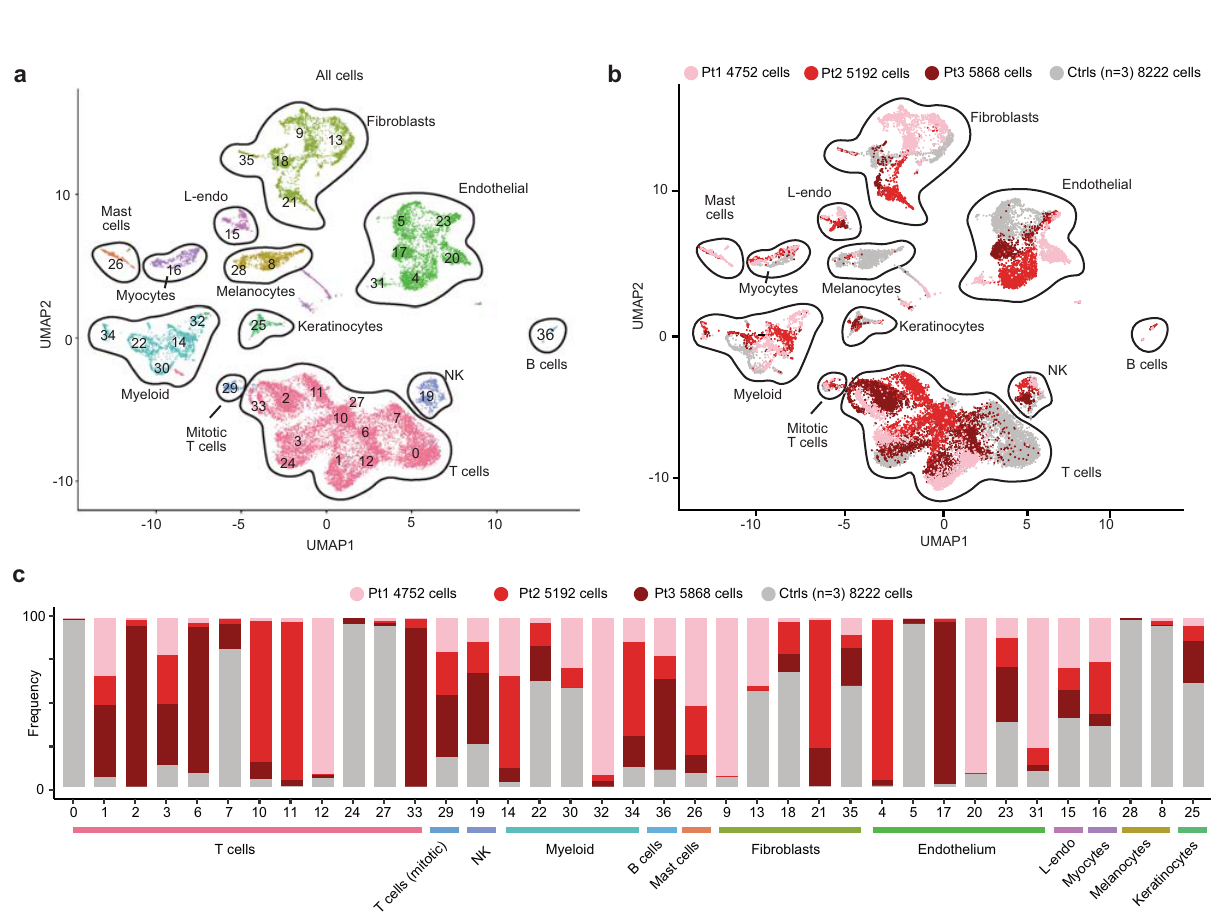
Fig. 2 Tofacitinib treatment leads to improvement in pulmonary and myocardial sarcoidosis. a, b PET (coronal) and PET-CT (axial) studies before and after 6 months of tofacitinib in patients with complete or near complete internal organ response, TLG: total lesional glycolysis. c PET (coronal) studies before and after 6 months of treatment in a patient with improvement in lymph node avidity below the threshold of quanti fi cation. d PET (coronal) studies before and after 6 months of treatment in a patient with a slight increase in PET avidity which was felt to be clinically insigni fi cant. e Cardiac PET-CT (coronal) before and after 6 months of treatment in a patient myocardial involvement of the inferior intraventricular septum (arrow), CMA: cardiac metabolic activity. f Scatterplot comparing change in cutaneous sarcoidosis and extra-cutaneous sarcoidosis. Depicted as simple linear regression line with 95% con fi dence interval (shared area), Goodness of Fit represented by R squared. Cutaneous involvement shown as percent reduction in CSAMI during the study period. Extracutaneous involvement shown as percent reduction in TLG during the study period; for patients with increase in TLG during the study, worsening of 25% was arbitrarily assigned. Source data are provided as a Data Source File.